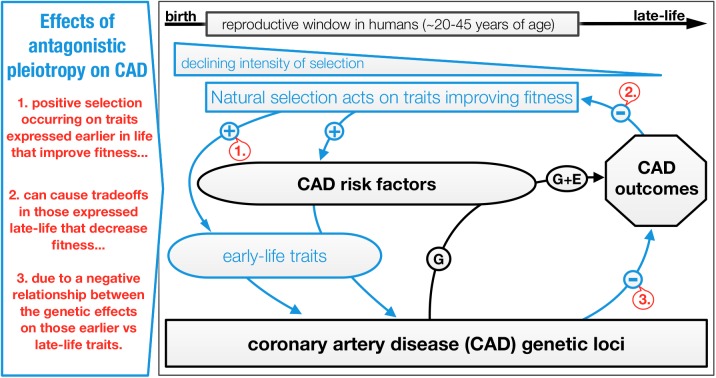
Conceptual figure of potential evolutionary tradeoffs between coronary artery disease (CAD) burden and other phenotypes as a consequence of antagonistic pleiotropy (AP) [42].As a simple example, AP describes gene effect on two traits (pleiotropy) that oppositely (antagonistic) affect individual fitness at different ages. Selection on that gene conferring a fitness advantage and disadvantage at different ages depends on the size and timing of the effects. An advantage during the ages with the highest probability of reproduction (between~20–45 years of age in humans) would increase fitness (lifetime reproductive success) more than a similarly sized disadvantage at later ages would decrease it. This concept is part of the well-known evolutionary theory of ageing, which describes tradeoffs in energy invested into growth, reproduction and survival [97]. In the figure above, intense natural selection occurring on CAD loci as a result of fitness advantages (+ signs, red text callout box 1.) conferred by genetically correlated risk factors (‘CAD risk factors’ box) or early-life traits (‘early-life traits’ box) trades off with the deleterious effects of these genes on fitness (i.e. CAD burden) later in life (- sign, red text callout box 2.) where the intensity of selection is weak. This occurs because of the negative relationship between genetic effects on early vs late-life traits (- sign, red text callout box 3.), which could help explain the high prevalence and maintenance of CAD in modern human populations. Over shorter timescales, lifetime probability of CAD is modified by a combination of genetic and environmental risk factors (e.g. [98]). There is evidence that such antagonistic effects have operated on CAD loci given: significant associations between CAD genetic risk and selection found (Figs 1 and 2); CAD genes are significantly enriched for lifetime reproductive success (S2 Table) and may also effect other early-life traits known to modify fitness (S4 Table); suggestive evidence was found for an antagonistic relationship between CAD and LRS (S3 Table); phenotypic selection has been found operating on CAD phenotypic risk factors [41].